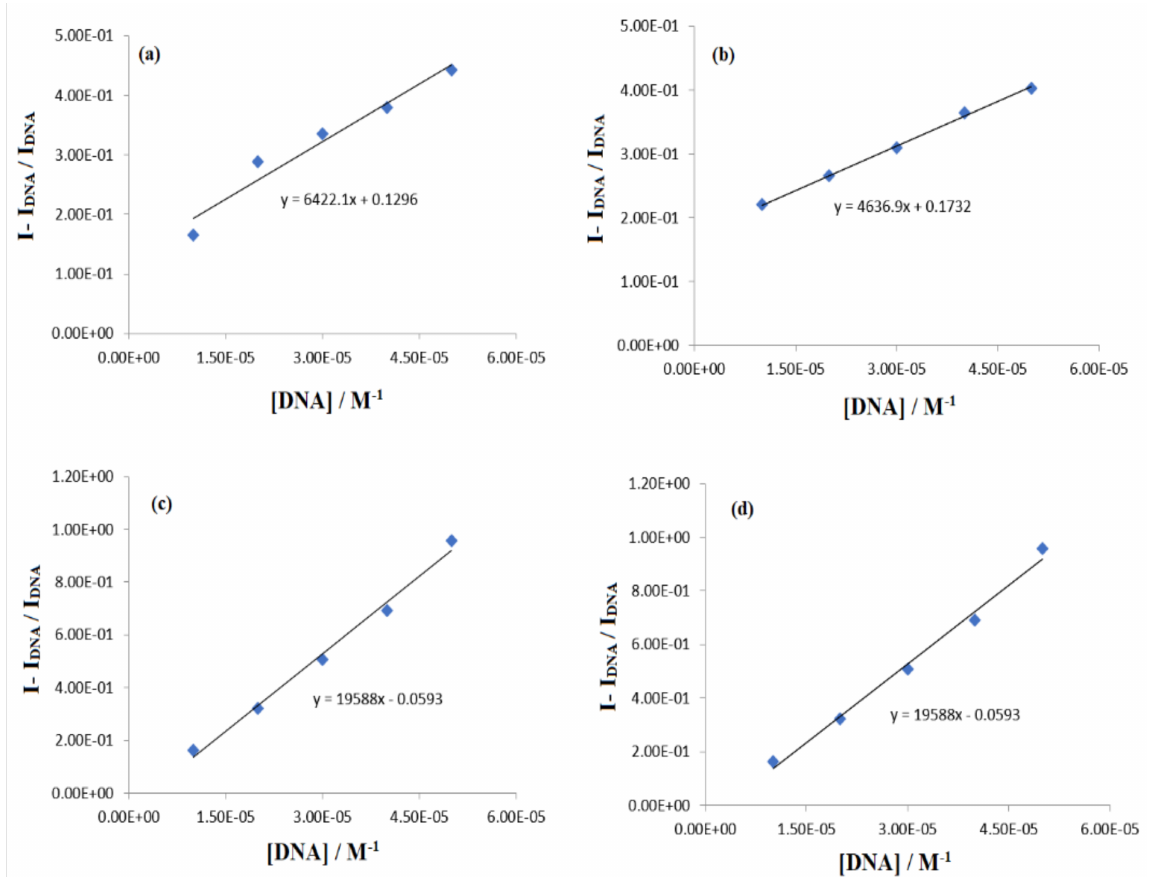
Figure 12. The plots of I − I DNA/ I DNA vs. [DNA] for the determination of binding site size of compound–[DNA] adduct with ( a ) IST-01, ( b ) IST-01, ( c ) IST-01, ( d ) IST-04. To further assure the compound–DNA complex formation, the irreversible redox activity of all compounds were scanned at different scan rates (0.1–0.13 V/s), with and without DNA. The overlay of cyclic voltammograms at various scan rates are provided in Supplementary Materials as Figure S15. The current variations with the square root of scan rates were plotted for all compounds and their DNA-bound complexes. The graphs are shown in Supplementary Materials as Figure S16. The data was further implemented in Randles–Sevcik Equation (7) to evaluate the diffusion coefficient (D o ) of all compounds and their DNA-bound complexes.